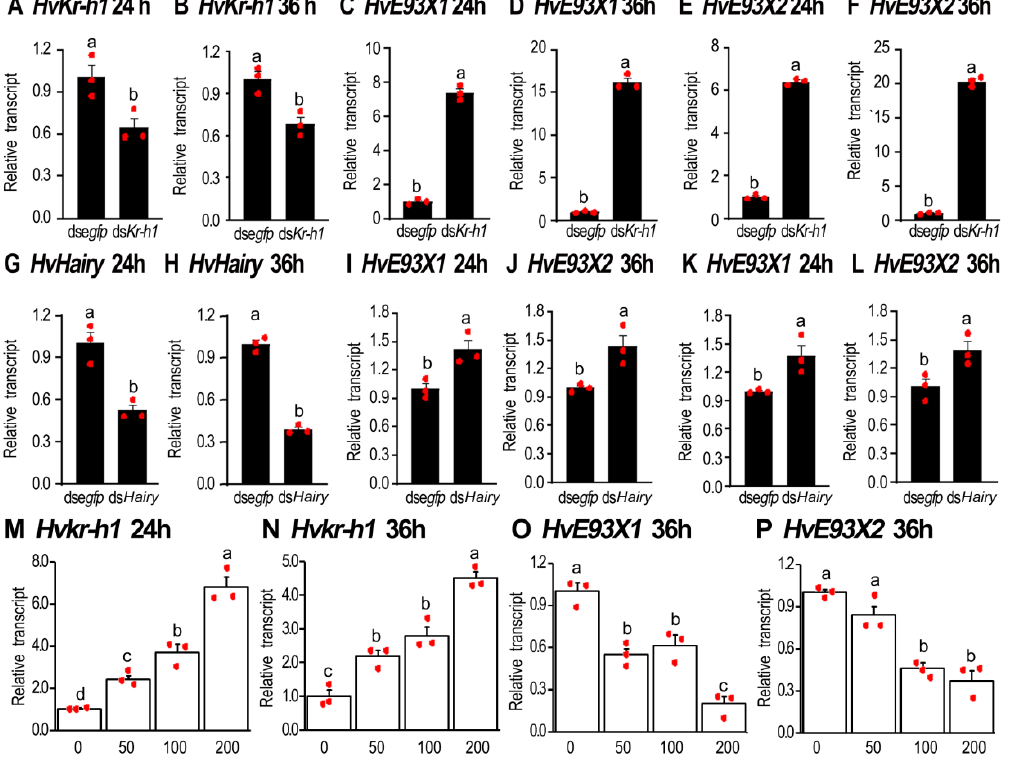
Figure 2. Disruption of the JH signal affects the expression of HvE93X1 and HvE93X2 in Henosepilachna vigintioctopunctata . Around 300 ng of ds Kr-h1 , ds Hairy or ds egfp (0.1 μ L) was injected into the newly-molted third instar larvae ( A – L ). Moreover, the ladybirds were confined in petri dishes containing potato foliage immersed with a JH solution at a concentration of 0, 50, 100 or 200 ng/mL ( M – P ). Twenty-four and thirty-six hours after injection, the expression levels (2 −ΔΔ CT values) of the target gene (either HvKr-h1 or HvHairy ), HvE93X1 and HvE93X2 were estimated. Different letters above the columns (means± SE) indicate a significant difference at p < 0.05 using an independent sample t -test ( A – L ) or an analysis of variance with the Tukey–Kramer test ( M – P ). However, any negative effects on the metamorphosis were observed in HvKr-h1 or HvHairy RNAi larvae or JH-ingested